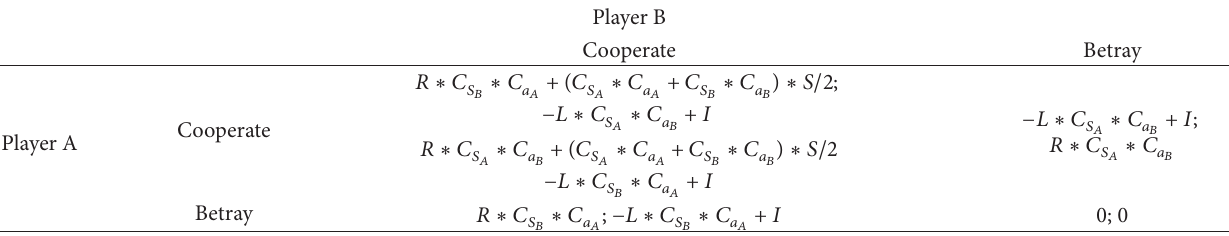
Table 3: The payoff matrix with the different firms’ capabilities while offering